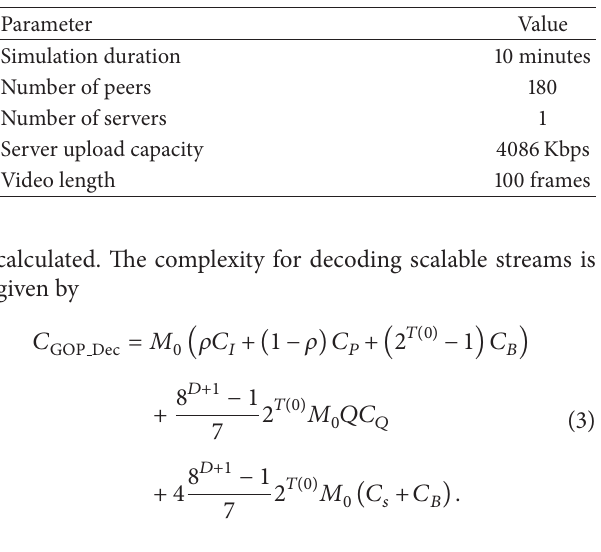
Table 3: Simulation